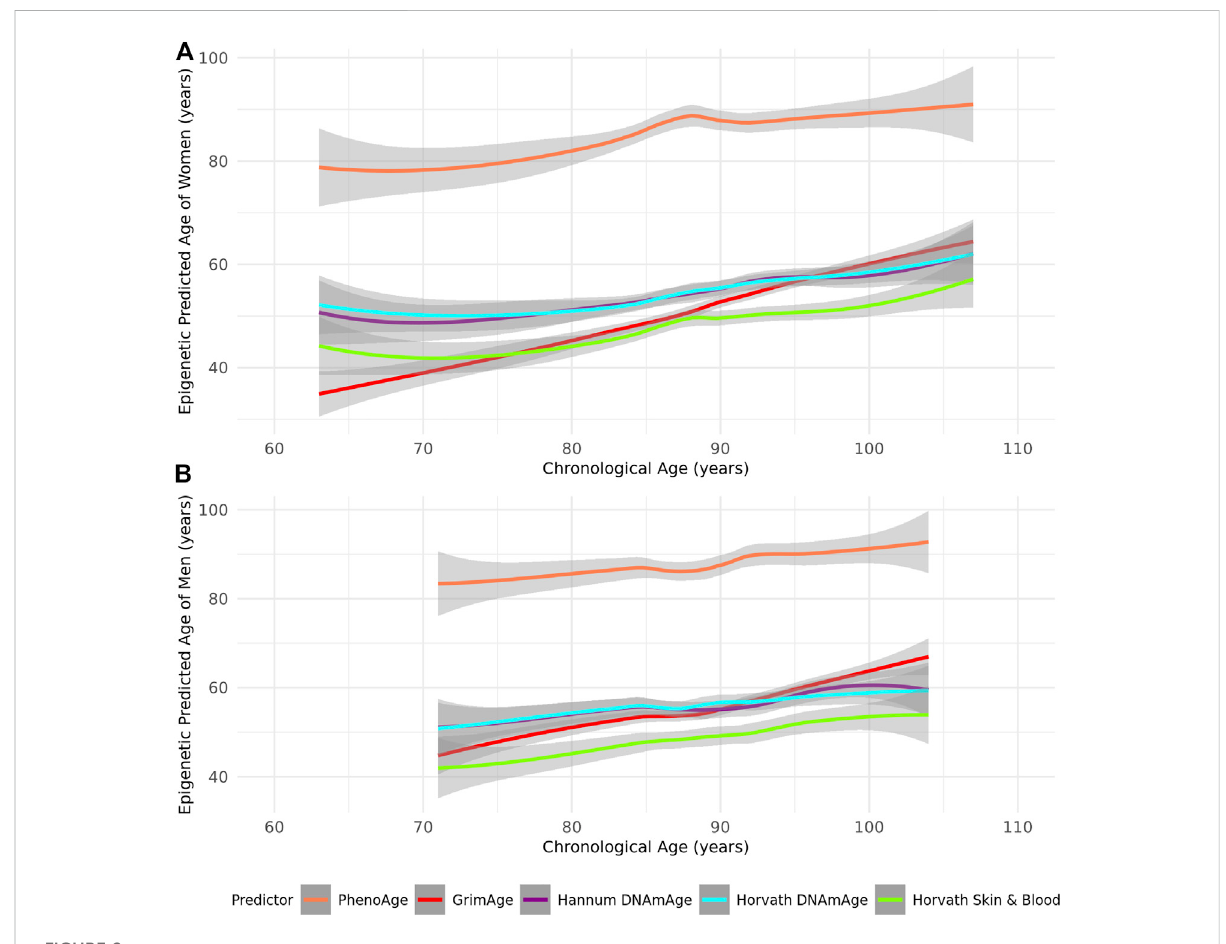
FIGURE 2 A Loess-smoothed curve of epigenetic predicted age with 95% con fi dence interval in grey against chronological age in years according to the PhenoAge, GrimAge,Hannum,Horvath,and SkinandBloodepigenetic agepredictorsin (A) femaleand (B) maleresidentsoftheMediterraneanBlue